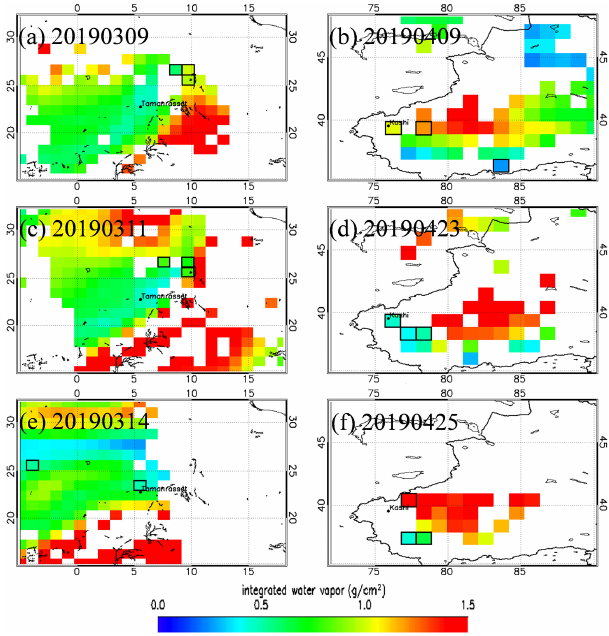
Figure 8. Integrated water vapor (g/cm 2 ) from the European Centre for Medium-Range Weather Forecasts (ECMWF) reanalysis dataset over the Sahara in March 2019 and over the Taklimakan Desert in April